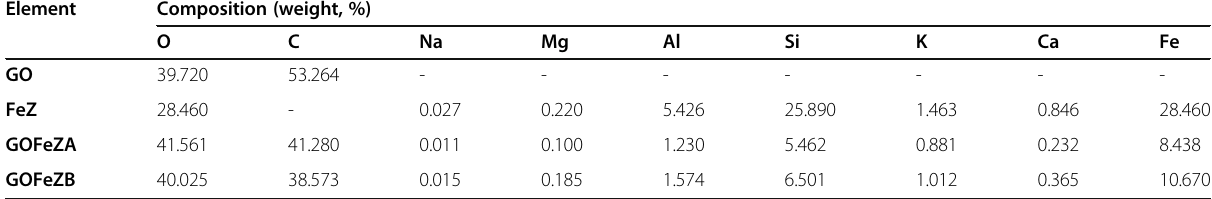
Table 1 Elemental compositions of GO, FeZ, GOFeZA, and GOFeZB Element